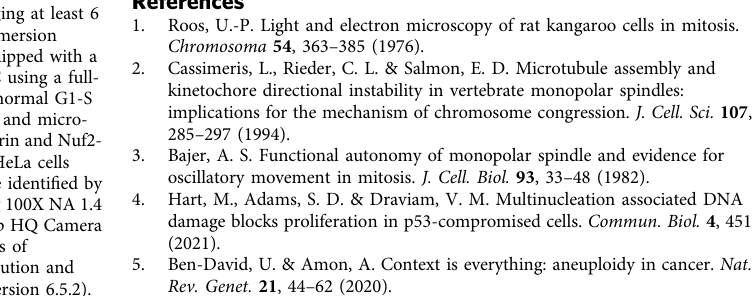
Fig. 7 Aurora-B and CDK1 pathways separately counteract Astrin at the outer kinetochore. a Representative images show YFP-Astrin 4A mutant localisation at kinetochores of monopolar spindles sequentially exposed to Aurora-B and CDK1 inhibitors. Cells depleted of endogenous Astrin and expressing YFP-Astrin WT or 4A mutant as indicated were treated with STLC for 45 min followed by MG132 and DMSO or ZM447439 (Aurora-Bi) or Roscovitine (CDK1i) or sequential addition of Roscovitine into ZM447439 (ZM447439 alone for 15 min with a Roscovitine supplementation for an additional 15 min, Aurora-Bi > CDK1i). Cells were immunostained with antibodies against GFP and Tubulin and CREST anti-sera. Scale bar as indicated. b Scatter plot of Astrin recruitment status showing the proportion of Astrin Crescent or Sleeve or no Astrin signal (Astrin Negative) bearing kinetochores in cells expressing YFP-Astrin WT or 4A mutant as indicated and treated with inhibitors as in a . Black bars and whiskers mark average value and standard deviation, respectively, across experimental repeats ( n = 4 repeats). Each dot represents a value from one cell. The colours of dots in b